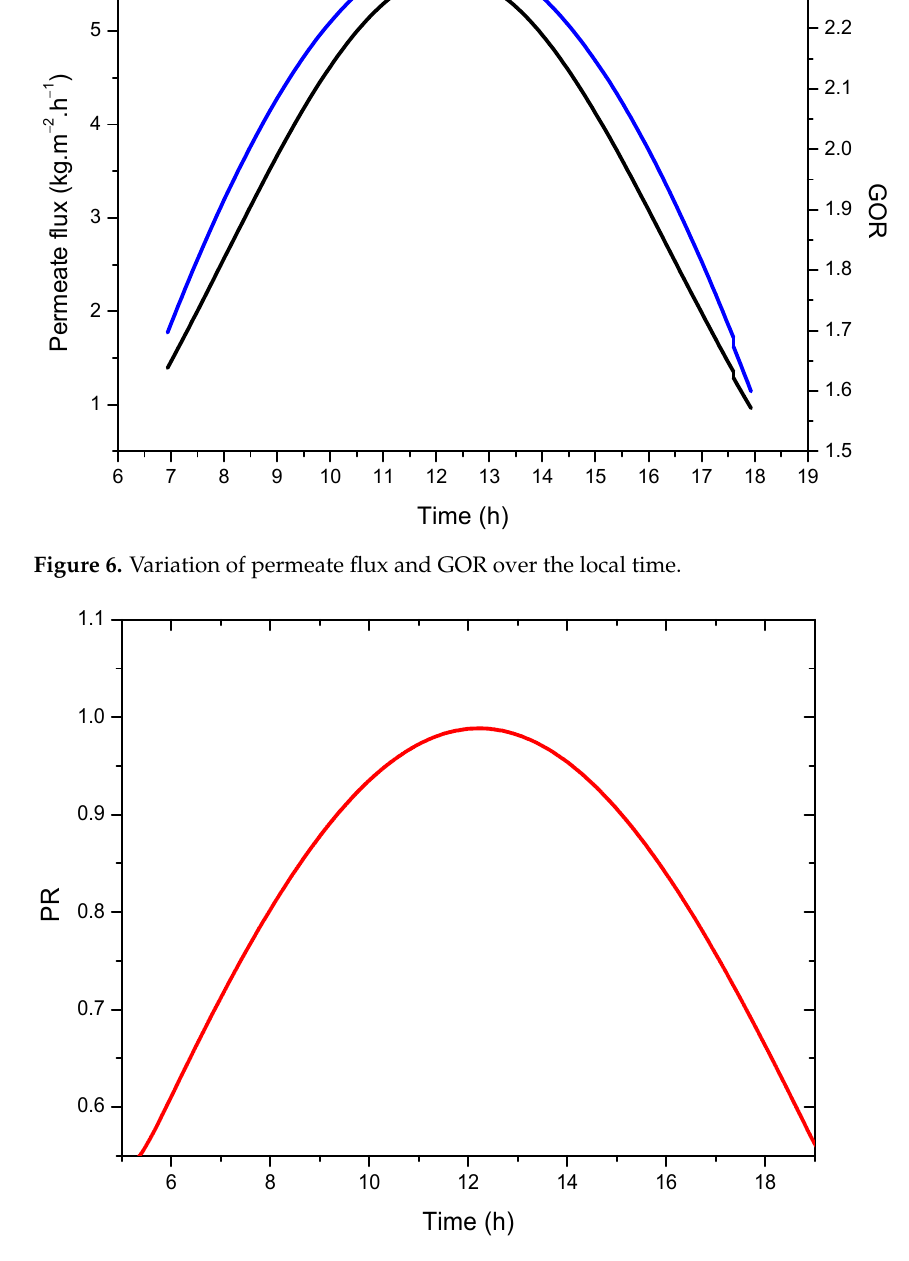
Figure 7. Variation of performance ratio over the local time.